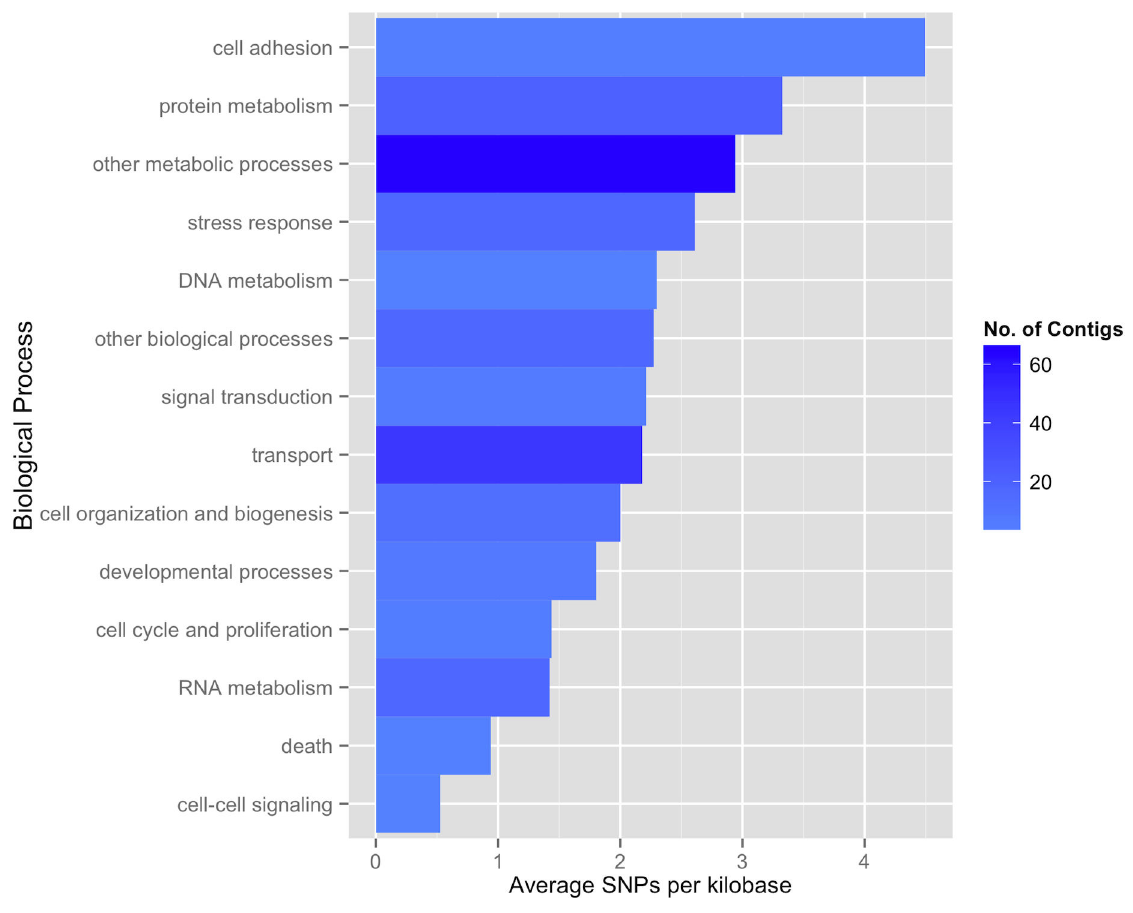
Figure 2. Average number of SNPs per kilobase pair in 152 contigs associated with GO Slim biological processes. Bar heights represent the average SNP rate per kilobase pair for select GO Slim biological processes. Color intensity of the bars indicates number of contigs for each GO Slim